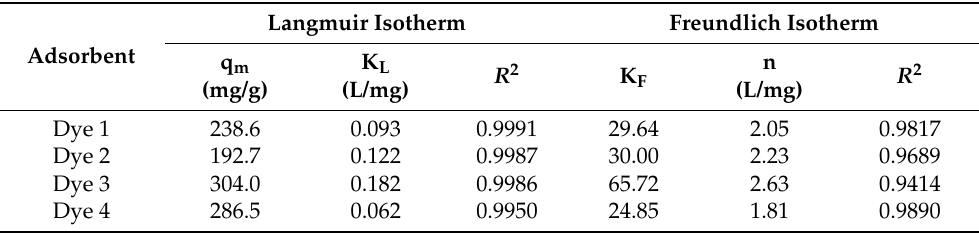
Figure 12. Freundlich isotherm plots for the investigated dyes (Dye 1–Dye 4). Table 4. Langmuir and Freundlich isotherm parameters for dye adsorption onto composite at pH 7.0 and 298 K.